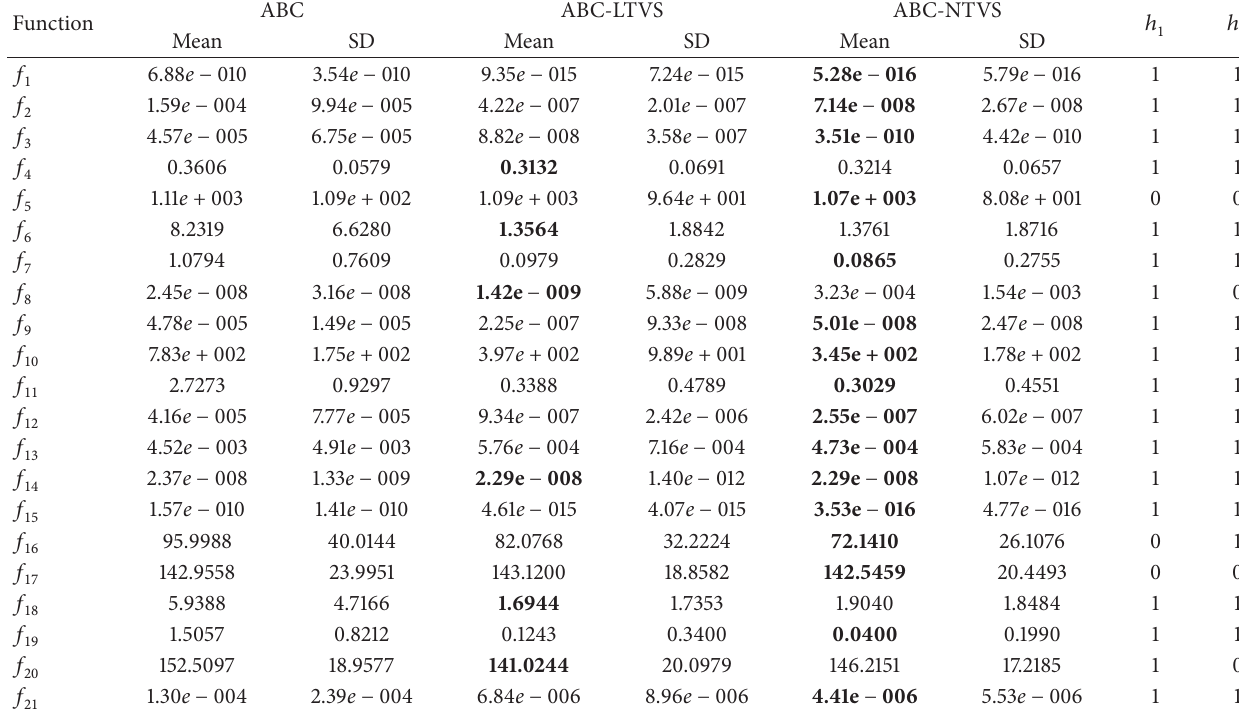
Table 6: Experimental results for 50-dimension problem.